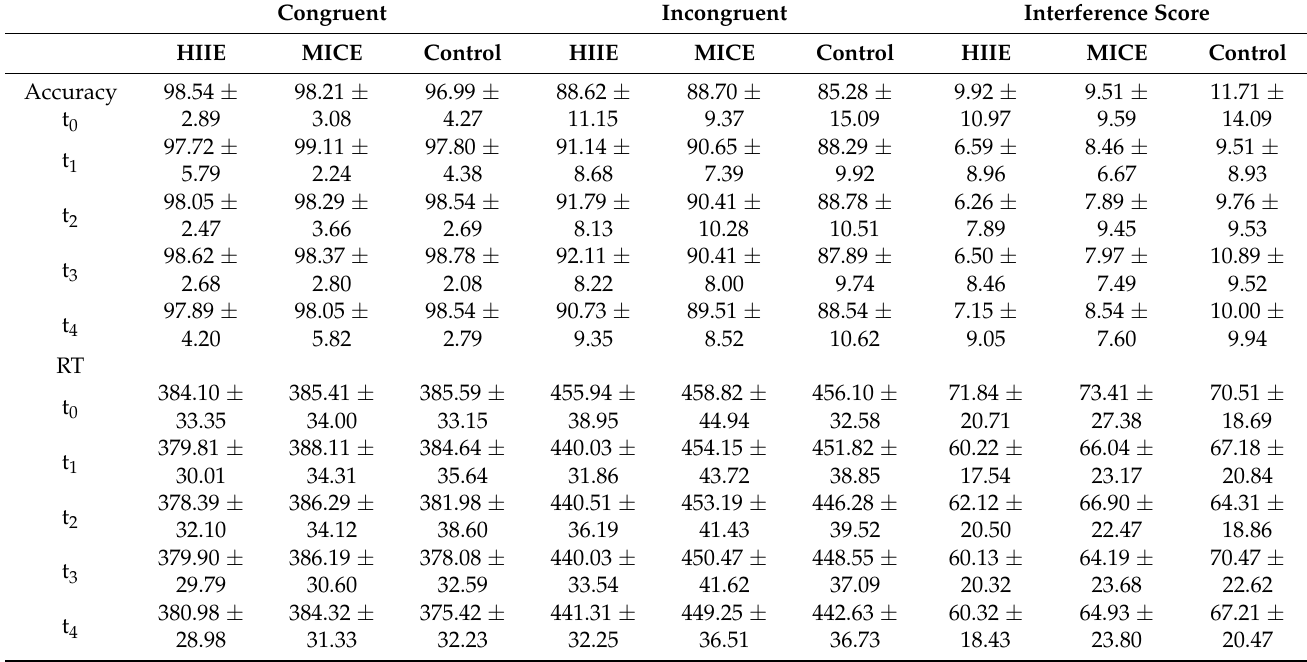
Table 2. Mean accuracies (%) and Response Times (RTs) (ms) for congruent trials and incongruent trials and interference scores of the flanker task. Data are shown as mean ± standard deviation ( M ± SD ). Congruent Incongruent Interference Score HIIE MICE Control HIIE MICE Control HIIE MICE